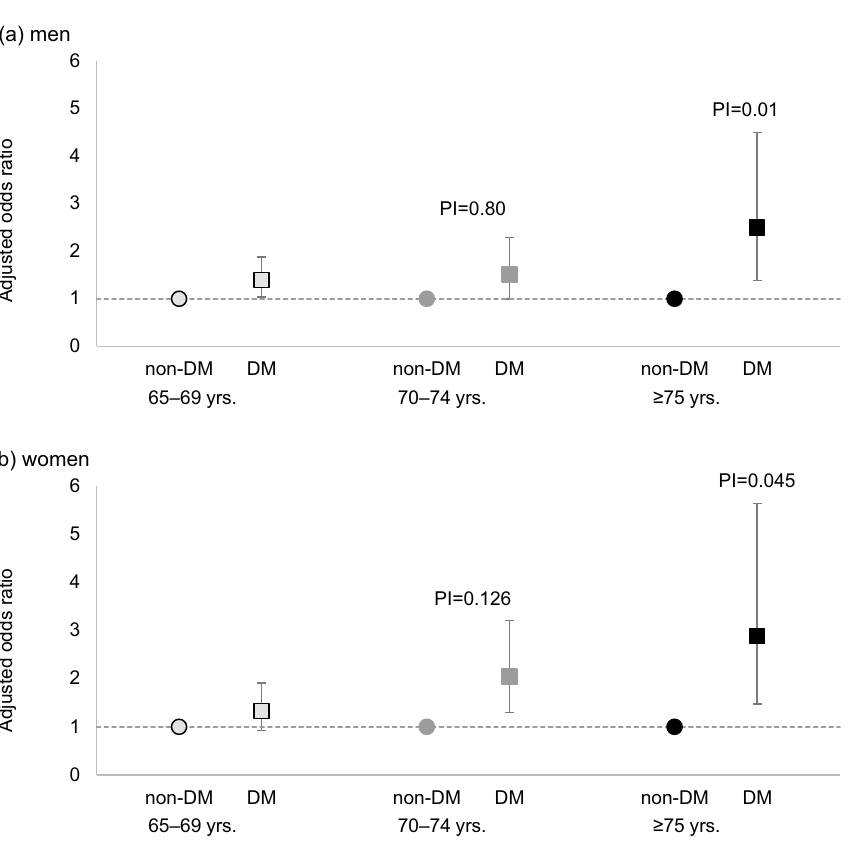
Figure 3. Adjusted odds ratios for low creatinine levels compared between participants without diabetes (n = 5380) and those with diabetes (n = 753) in men and women. The model was adjusted for age and body mass index. The low creatinine levels were defined as those which were less than the 25 percentile (25 percentiles were 61.9 μmol/l in men and 53.0 μmol/l in women, respectively). DM diabetes mellitus, PI p-value for the interaction of the diabetes status and